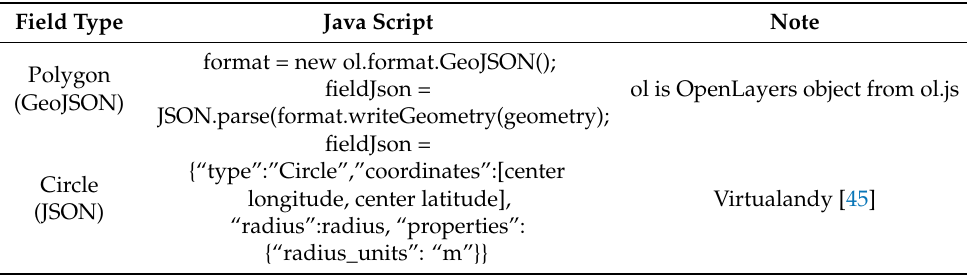
Table 4. Creation of Field Geometry as JSON